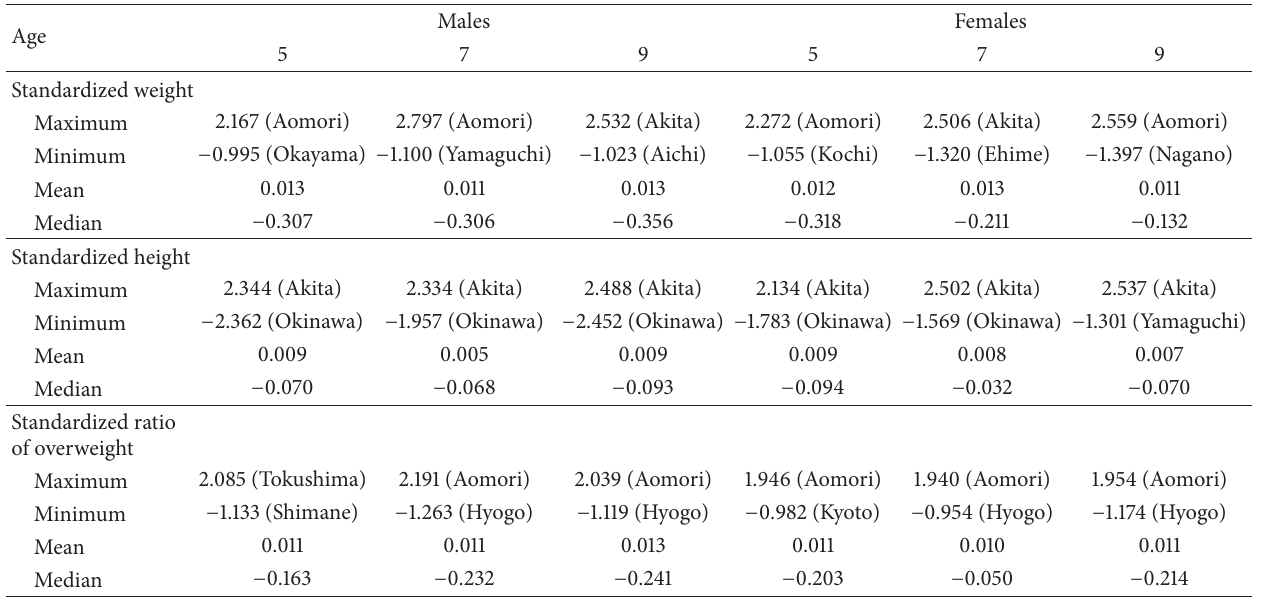
Table 1: Basic statistics for standardized weight, height, and prevalence rate of overweight.